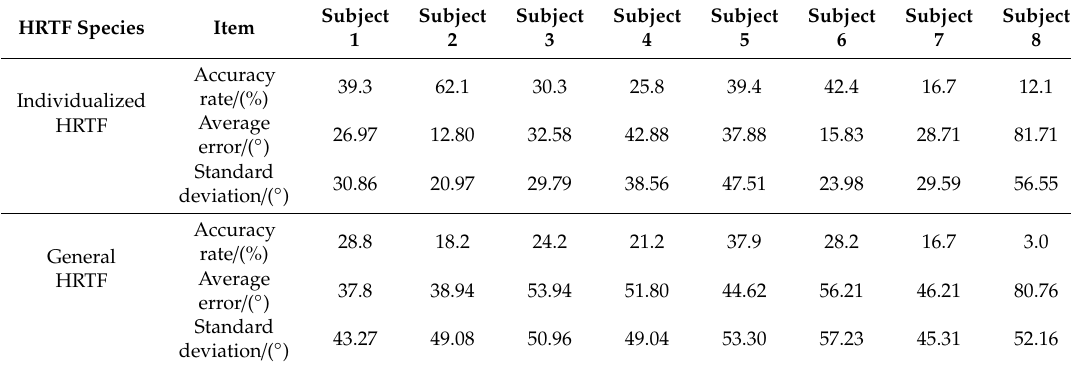
Table 7. Statistical results of the localization experiment.